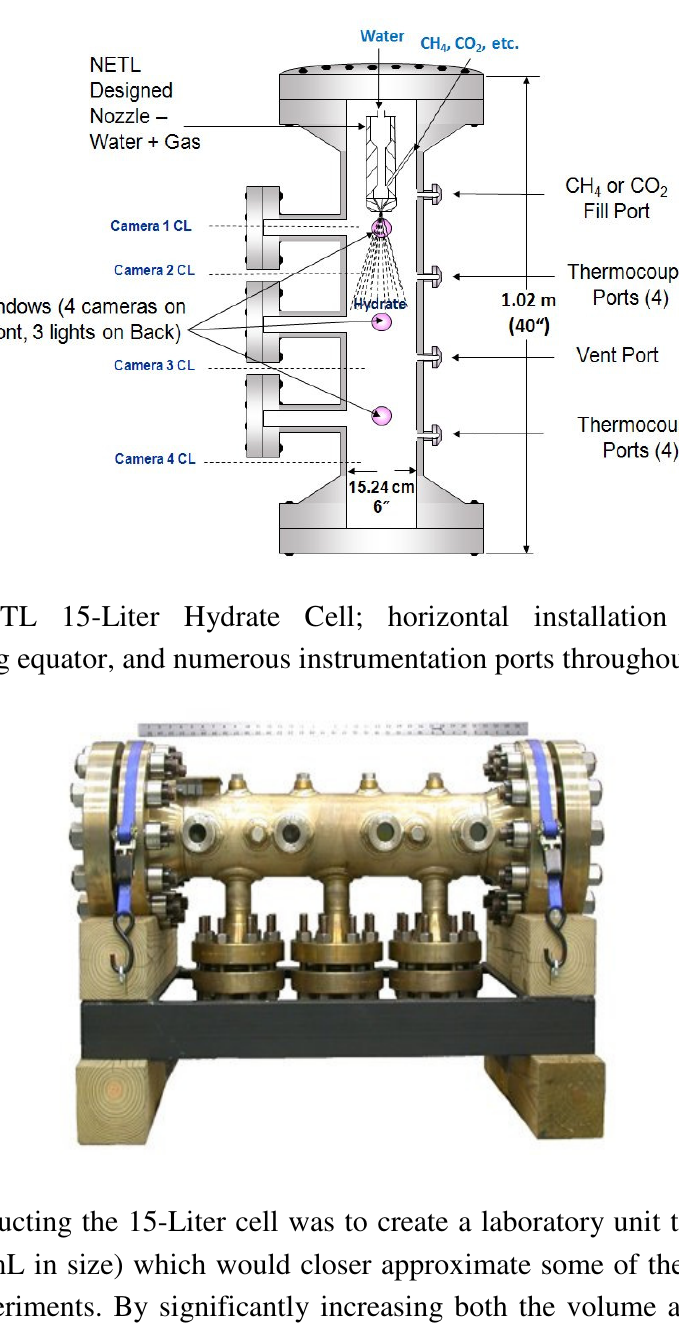
Figure 10. Schematic of NETL 15-Liter Hydrate Cell utilized for rapid hydrate formation experiments.